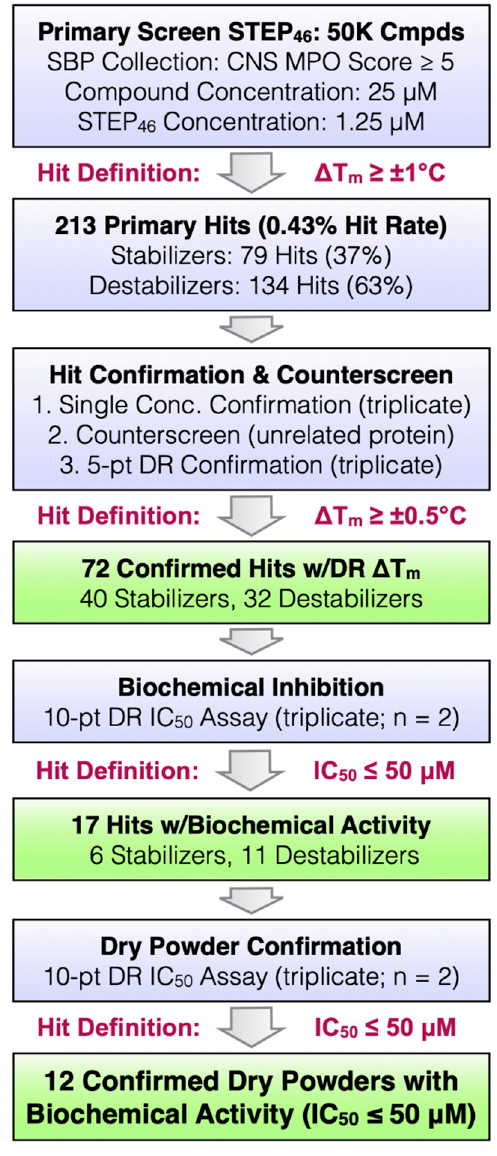
Figure 5. STEP 46 HTS go/no-go decisions and summary of results.